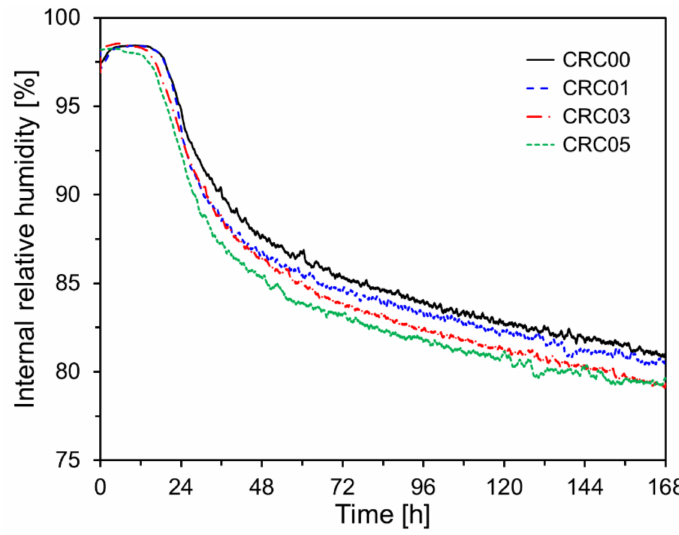
Figure 12. IRH of CNT-reinforced cement composites.